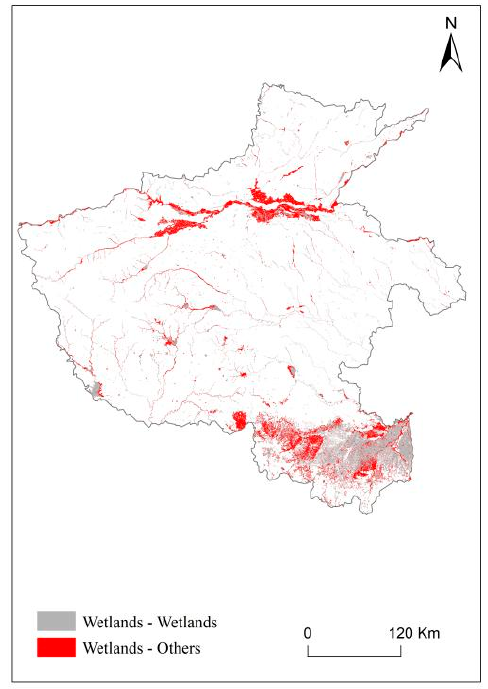
Figure 6. Transformation between wetlands and “Others” from 1980–2015.